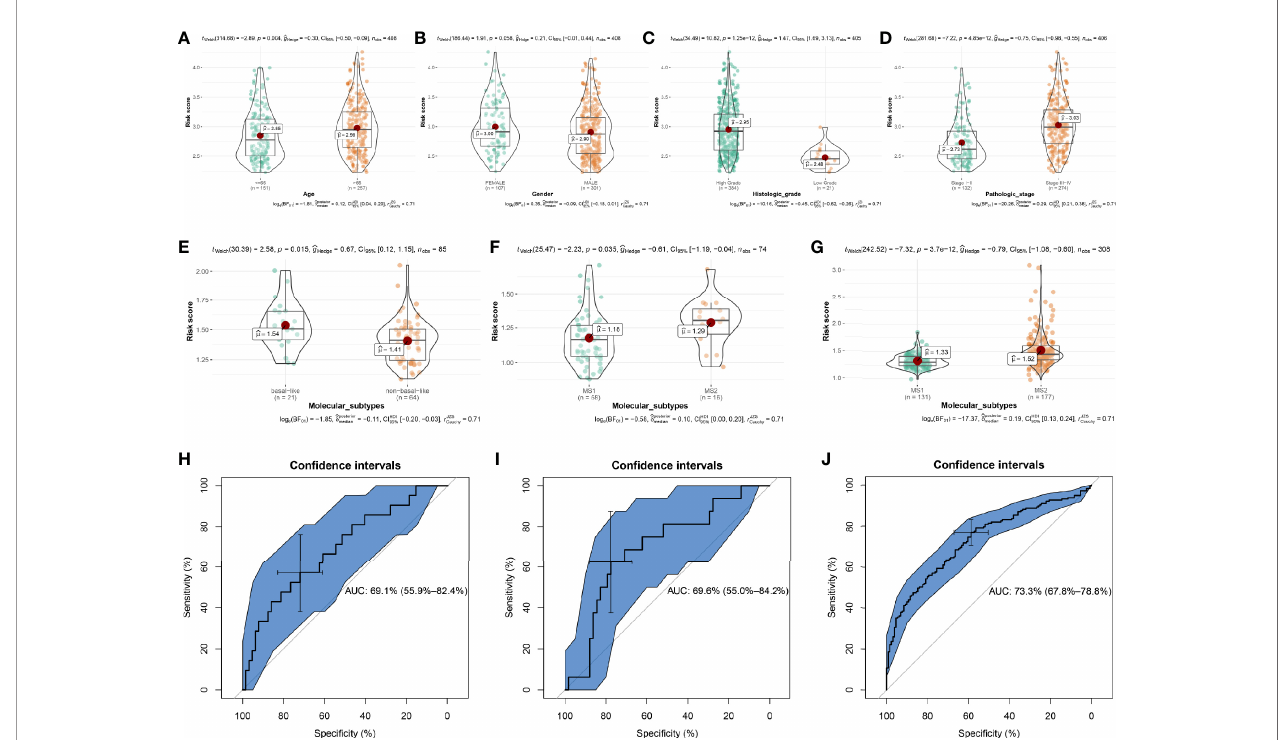
FIGURE 6 | The relationships between the risk score and clinicopathological variables and the prediction value of risk score to molecular subtypes. The relationships between the risk score and (A) Age. (B) Gender. (C) Histologic grade. (D) Pathologic stage. The relationships between the risk score and molecular subtypes (non-basal-like/MS1 vs basal-like/MS2) by using E-MTAB-1803 (E) , GSE19915 (F) , and GSE32894 (G) . Receiver operating characteristic (ROC) curves and area under the curve (AUC) statistics to evaluate the diagnostic ef fi ciency of risk score to bladder cancer aggressiveness in E-MTAB-1803 (H) , GSE19915 (I) , and GSE32894 (J)